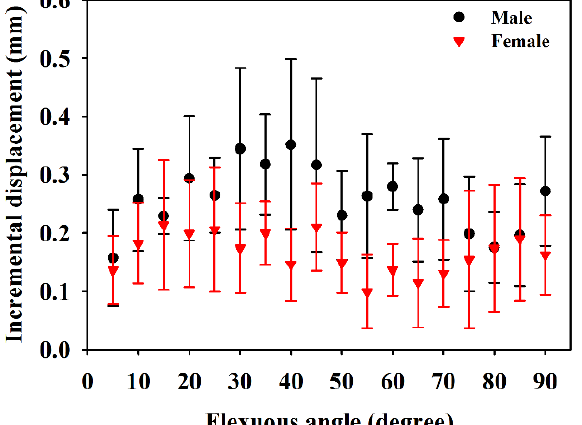
Figure 8. Incremental displacements of the MN in total direction for males and females while flexing fingers from 0° to